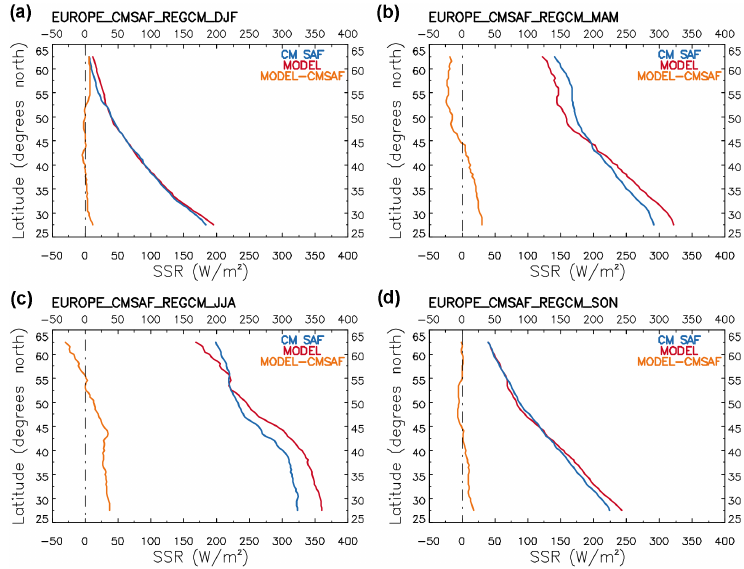
Figure 2. Latitudinal variability in RegCM4 SSR (red), CM SAF SSR (blue) and their difference (orange) over Europe for (a) winter (DJF),